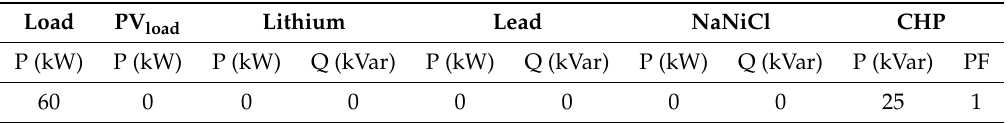
Table 4. Initial values set for Test 4.